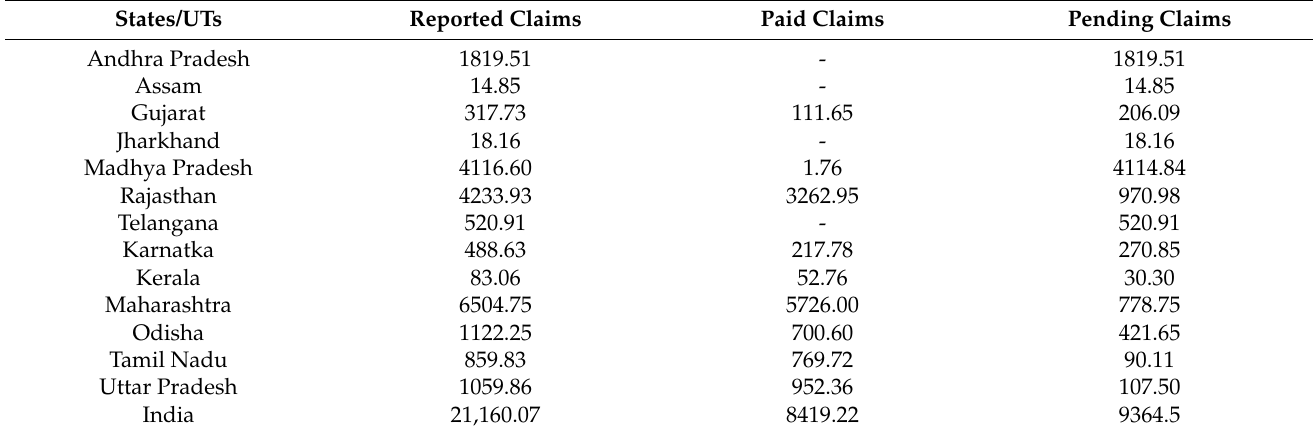
Table 7. State-wise pending claims under PMFBY in 2019–2020 (Rs. in